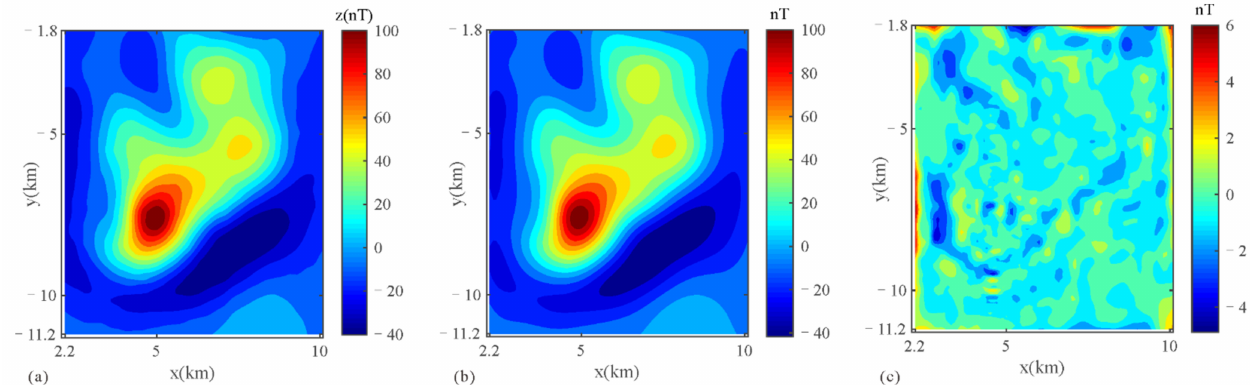
Figure 15. High-value area of magnetite-caused RTP anomaly maps in Dazhang Pluton subregion: ( a ) observed data; ( b ) predicted data from the inversion model; ( c ) difference between the observed and predicted data.